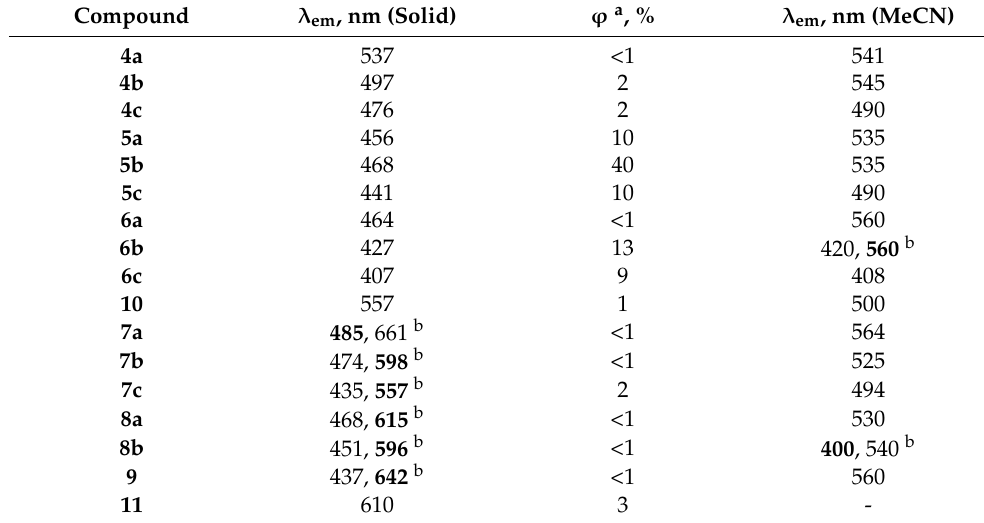
Table 3. Photoluminescence data for compounds 4 – 9 and 11 in powder at r.